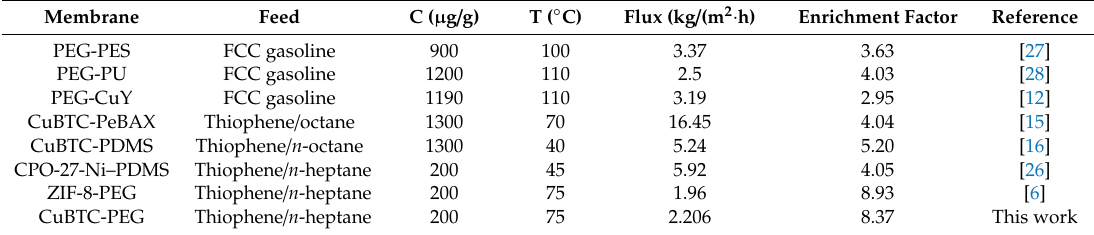
Table 1. Desulfurization performance of different membranes.